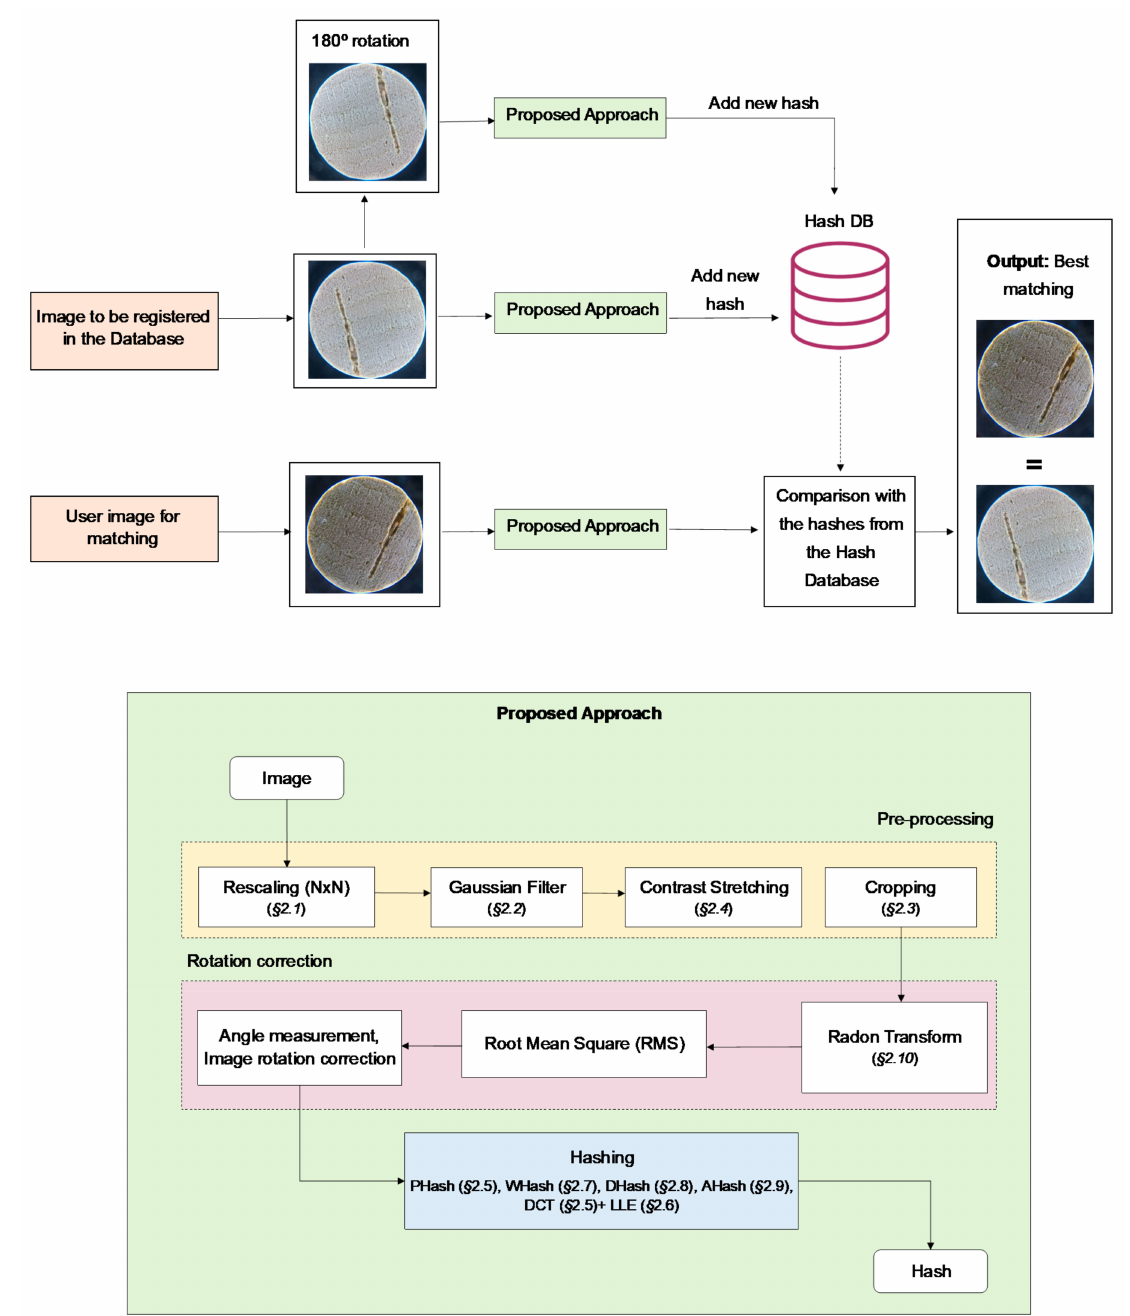
Figure 5. Block diagram of the cork authentication process; proposed hash-based